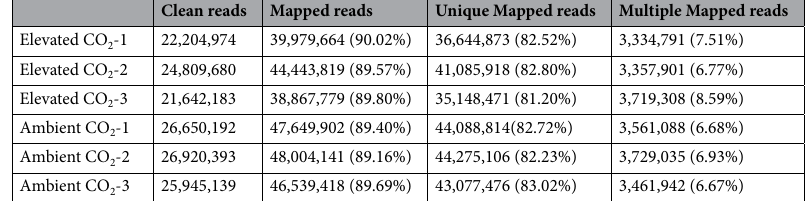
Clean reads Mapped reads Unique Mapped reads Multiple Mapped